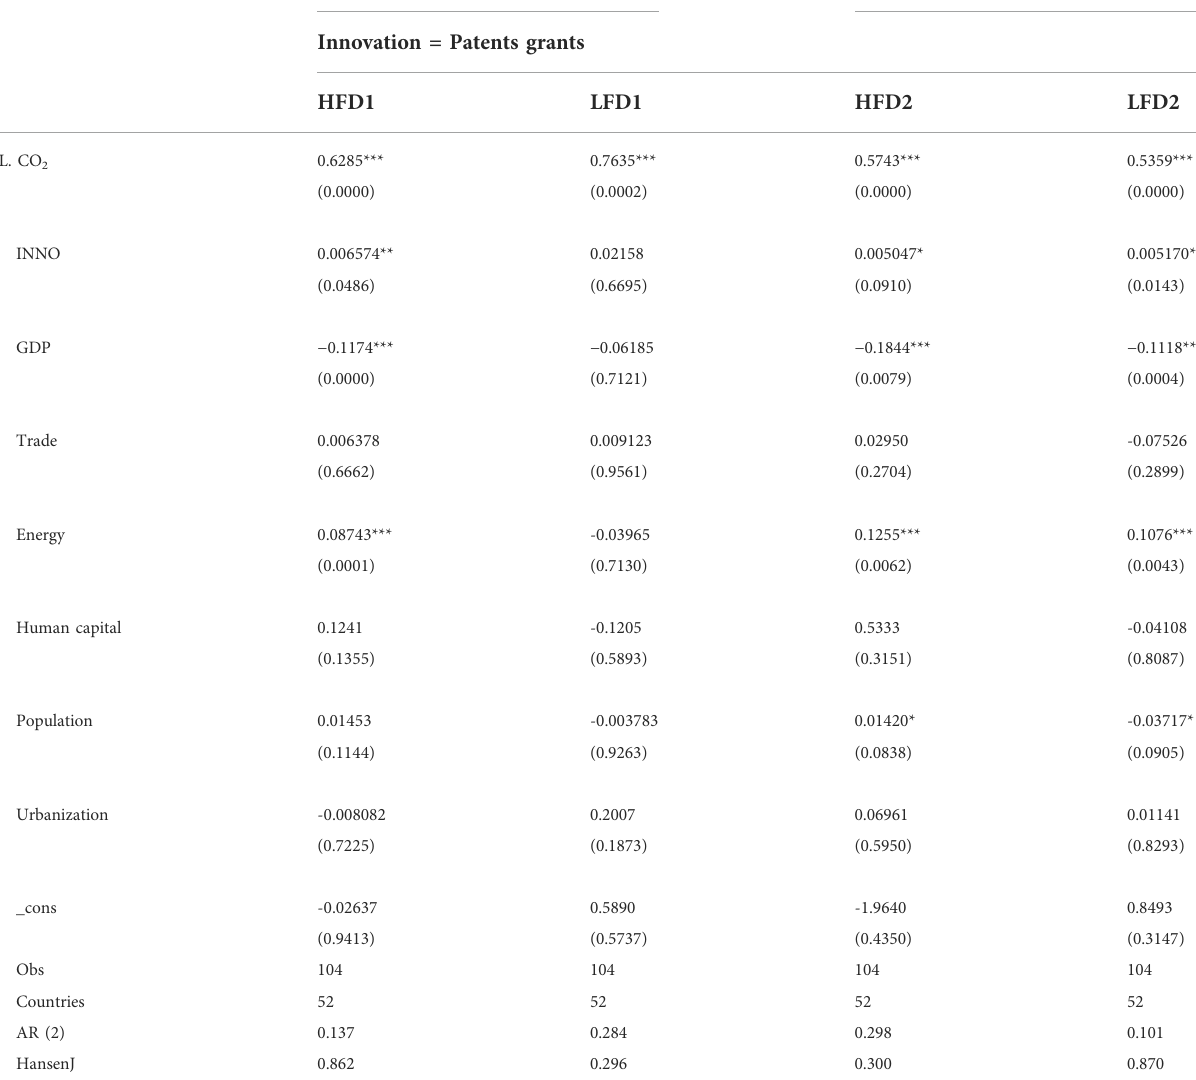
TABLE 5 Financial development, Innovation, and environment quality: 1990 – 2014. (Innovation = Patents